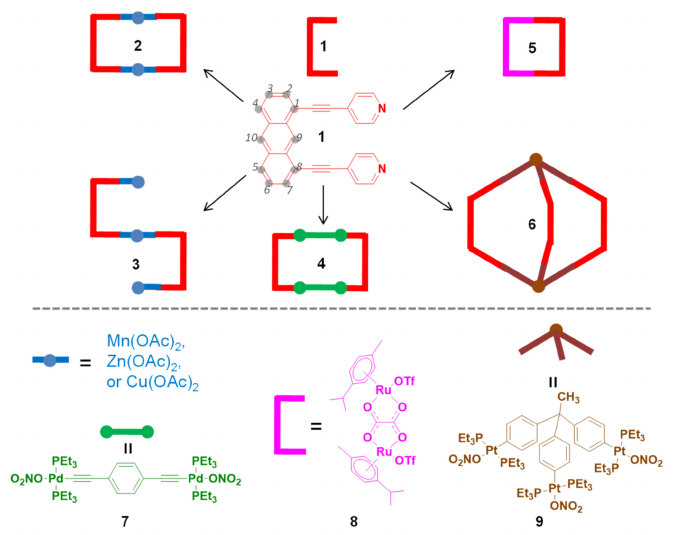
Figure 1. Nitrogen-based anthracene-containing ligand 1 for constructing coordination self- assemblies. The numbering scheme for the carbon atoms in anthracene is displayed along with the structure of ligand 1 .